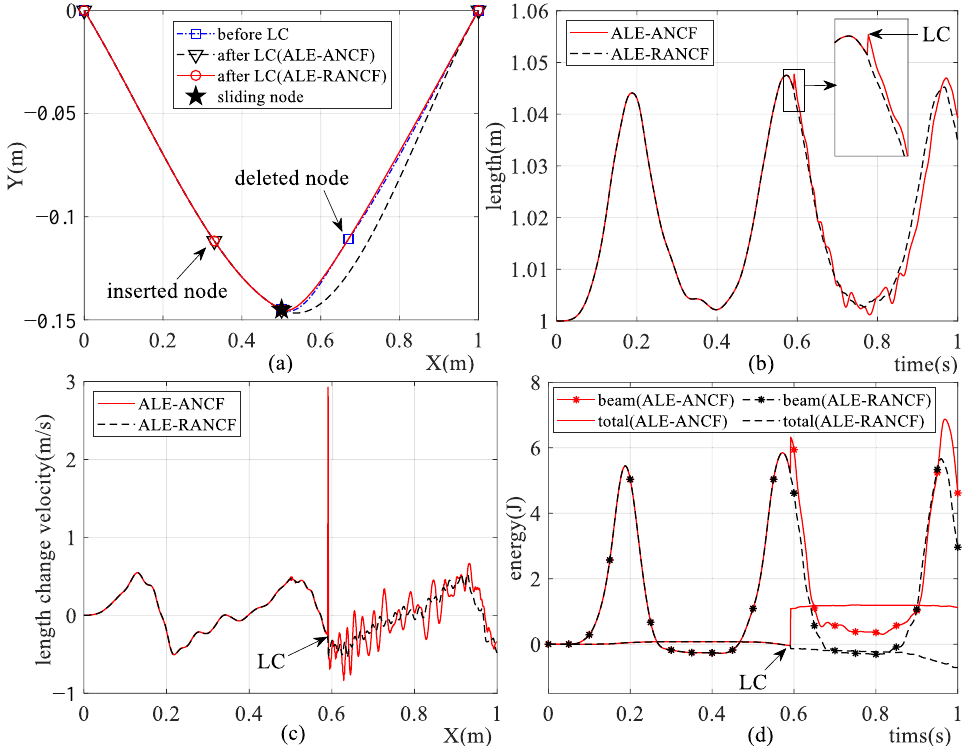
Figure 14. Simulation results of ALE-RANCF and ALE-ANCF model, including ( a ) model configura- tions, ( b ) length of beam, ( c ) change velocity of beam length, and ( d ) system